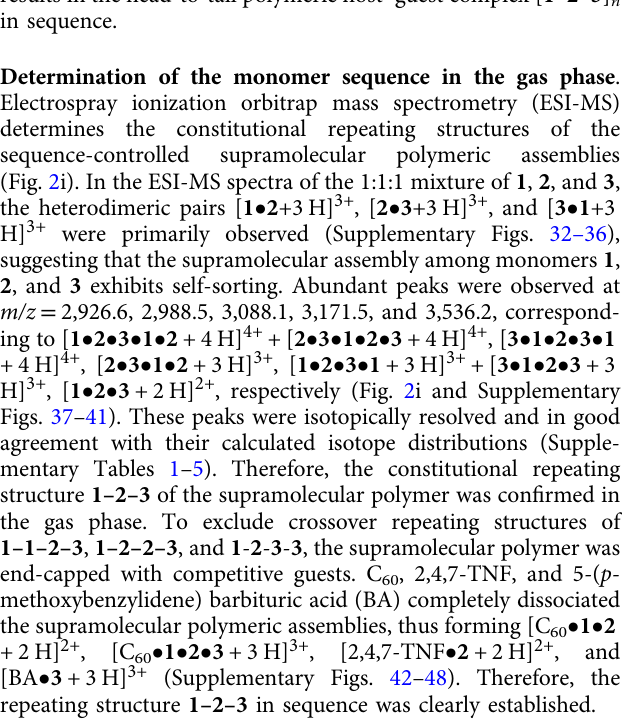
(Fig. 2h). The 1 (cid:129) 2 , 2 (cid:129) 3 , and 1 (cid:129) 3 host – guest complexes were